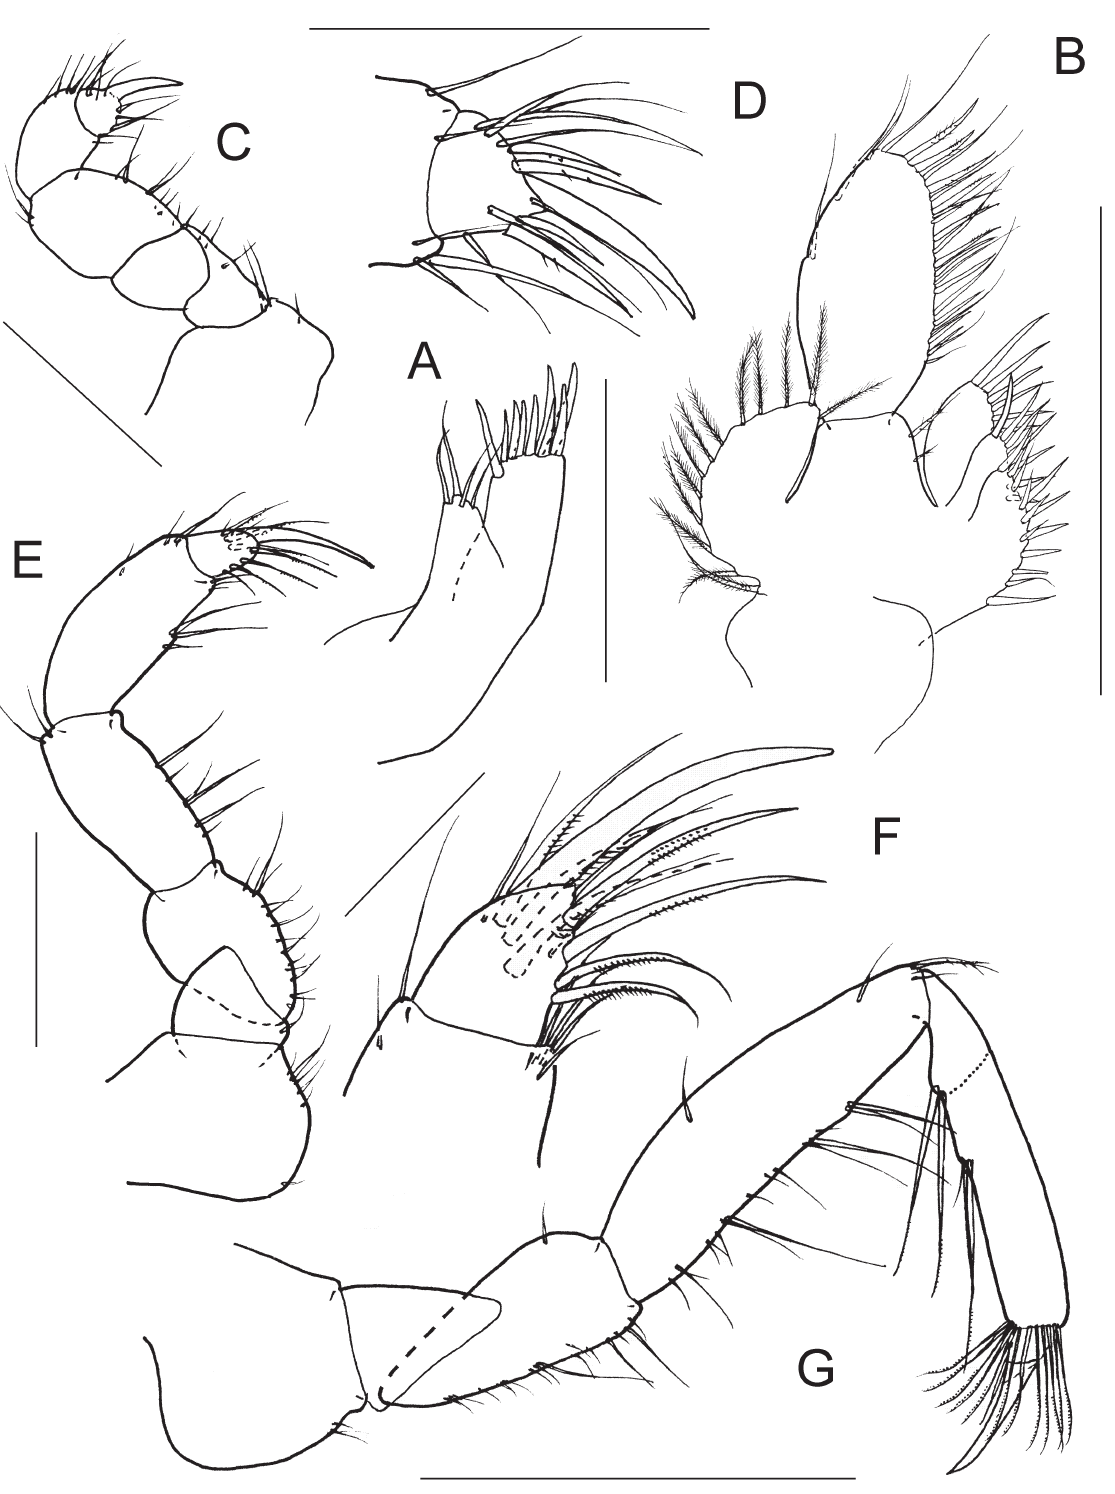
Fig. 12. Siriella hanseni W.M. Tattersall, 1922, lectotype, ♂, length 5.5 mm, Laccadive Sea, Gulf of Manaar, India. A . Maxilla 1, posterior view, B . Maxilla 2, posterior view. C . Endopod of maxilliped 1, posterior view. D . Dactylus of maxilliped 1, posterior view. E . Endopod of maxilliped 2, posterior view. F . Dactylus of maxilliped 2, posterior view. G . Endopod of pereopod 1, posterior view. Scale bars: A–C, E, G = 0.25 mm; D, F = 0.1